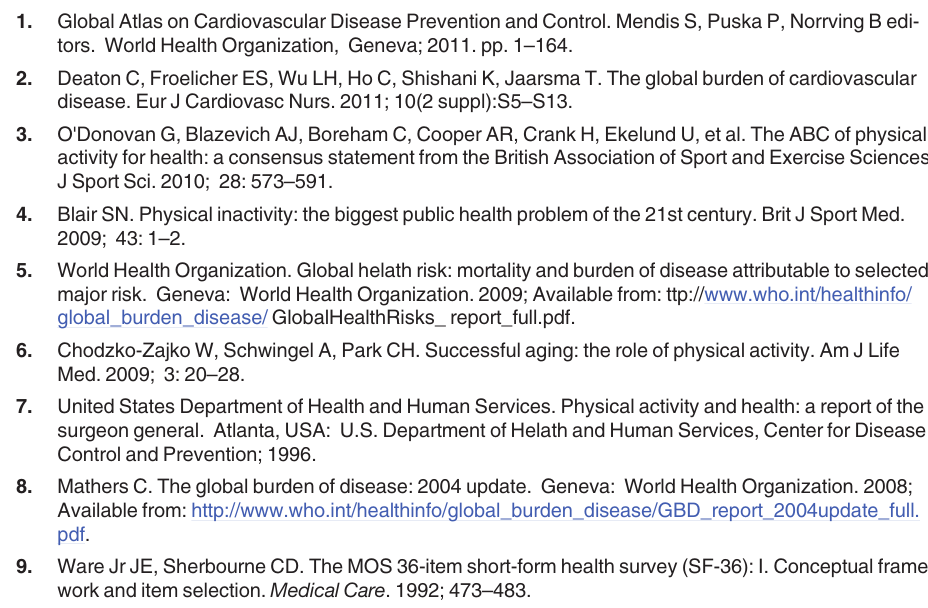
S1 Table. Health-related quality of life dimension and component scores by gender and cardiorespiratory fitness level. Health-related quality of life dimension scores, and physical (PCS) and mental (MCS) component scores (Mean, SD) by gender and cardiorespiratory fit- ness quartiles